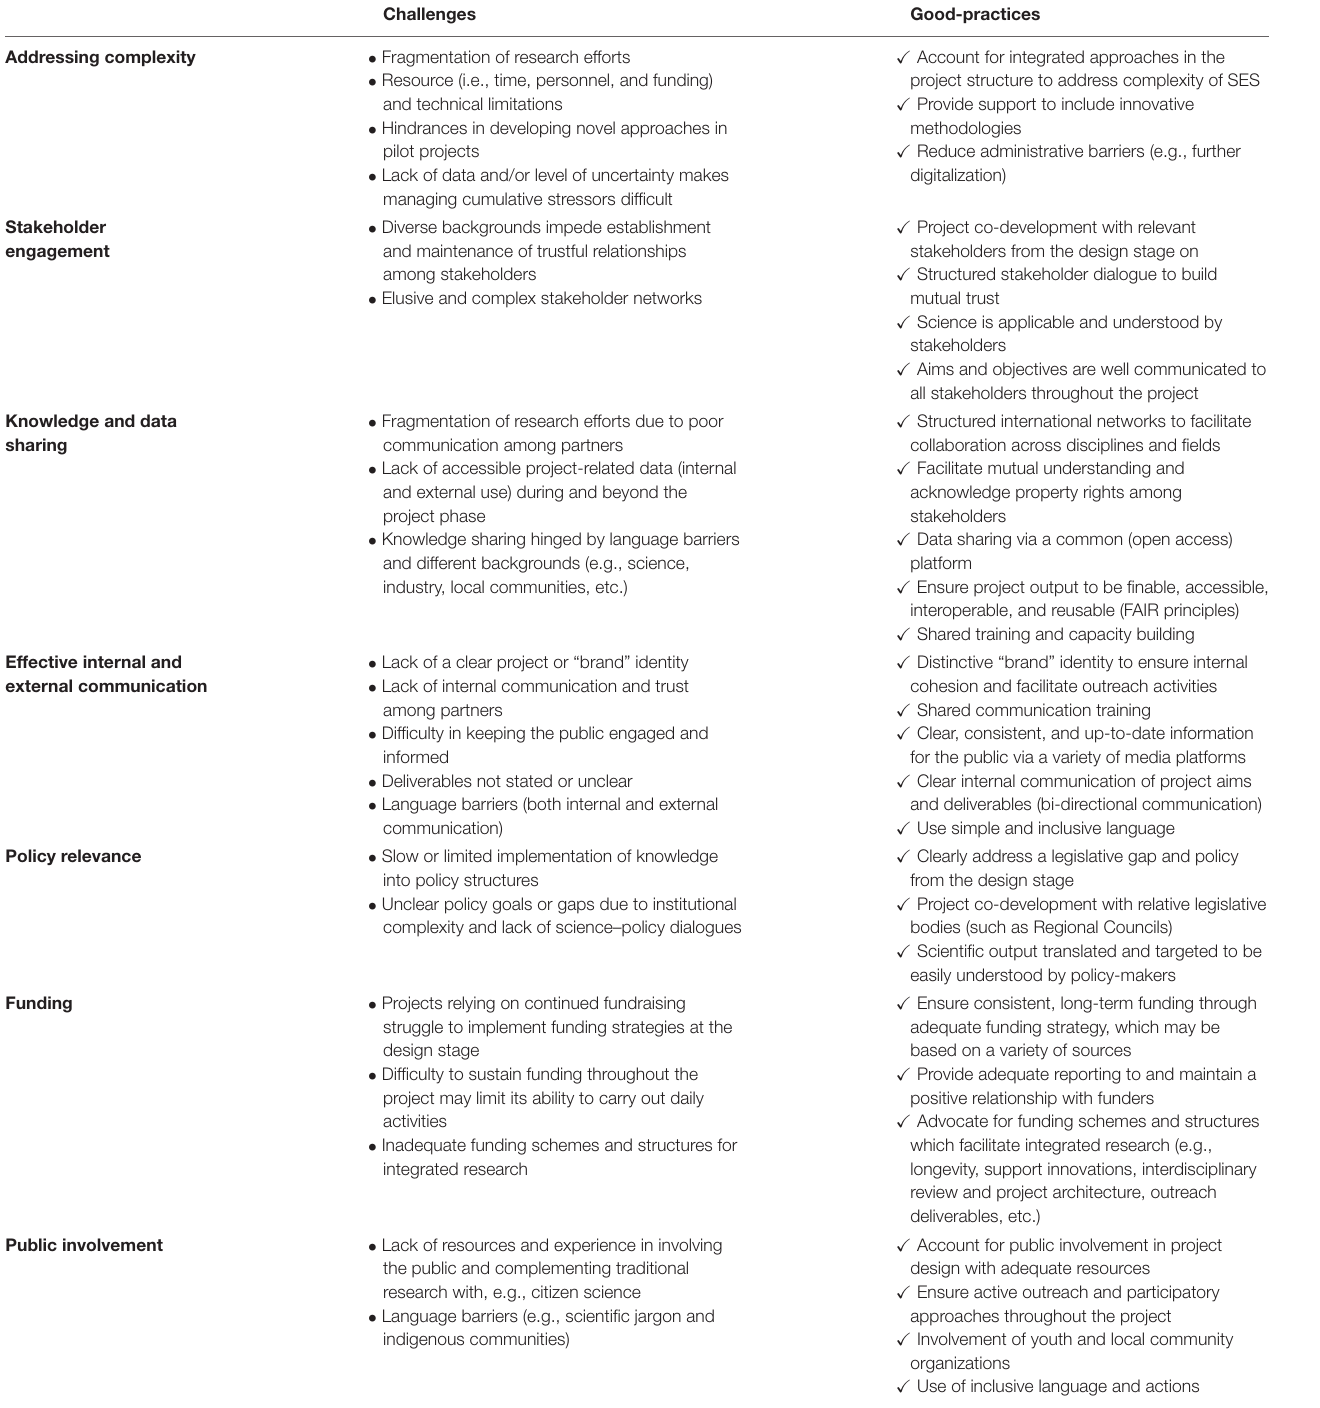
TABLE 1 | Challenges and good-practices mentioned by surveyed projects and